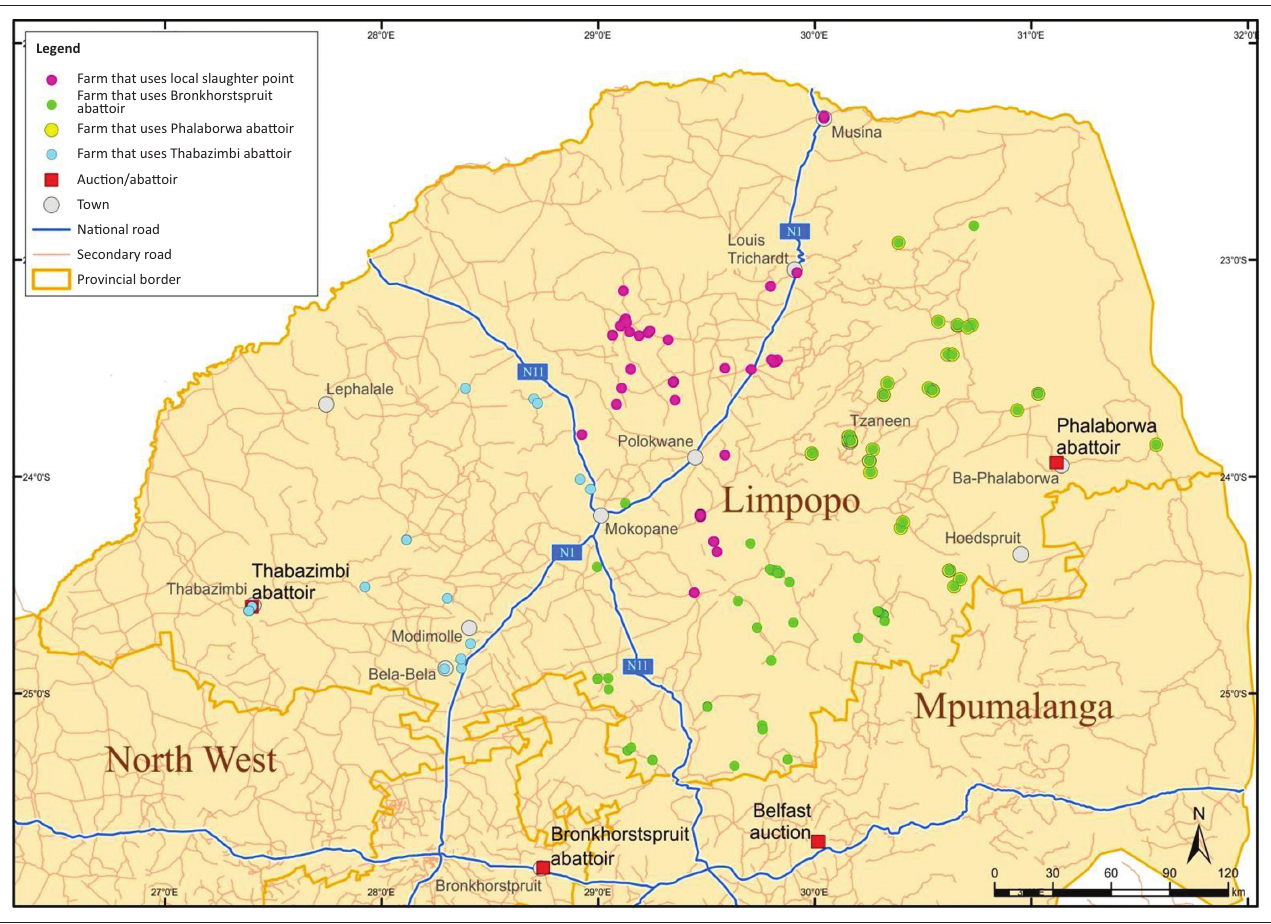
FIGURE 3: Distribution of locations of surveyed farms based on preferred slaughter location/auction markets and the national and secondary road networks.